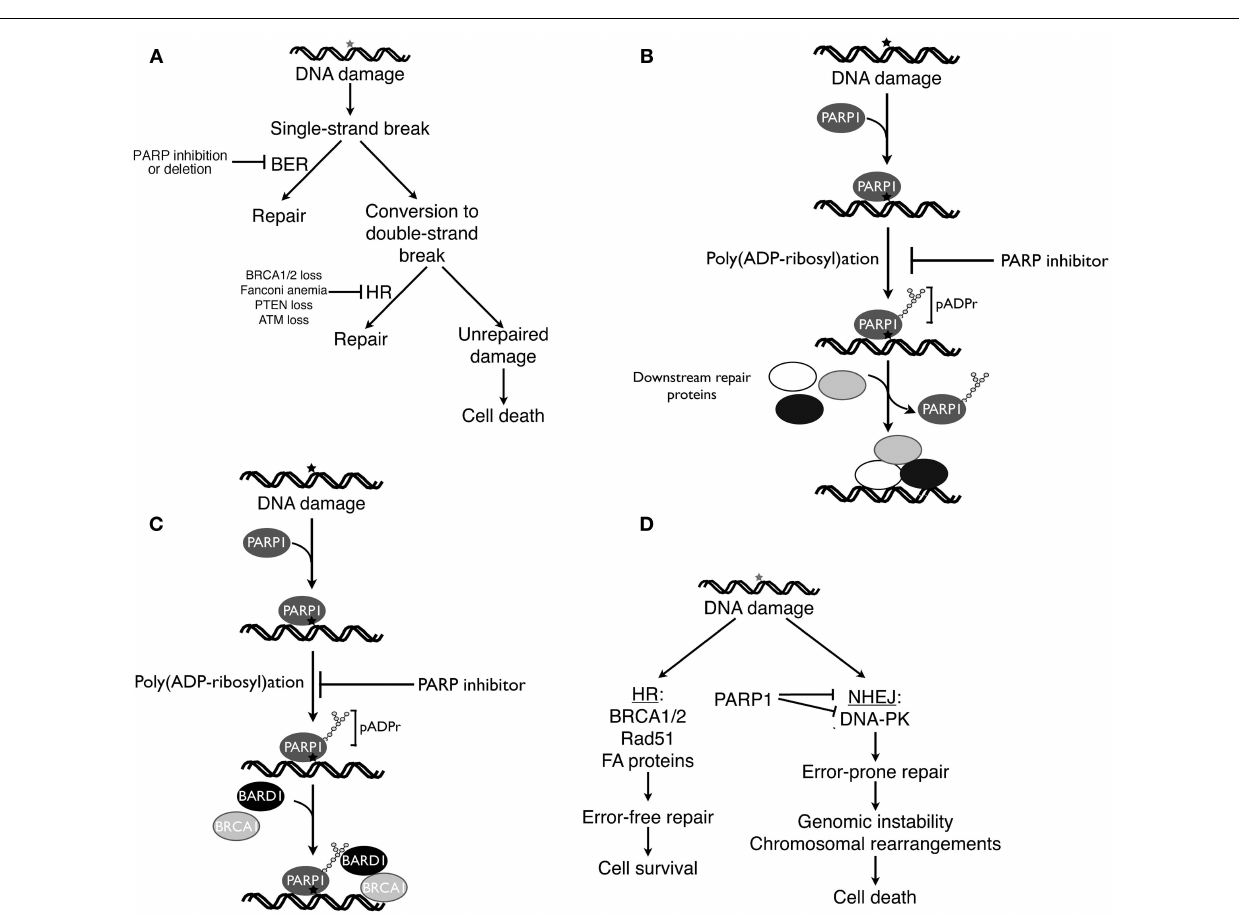
FIGURE 2 | Four current models of PARP inhibitor-induced cancer cell killing . (A) , classical explanation of PARP inhibitor cytotoxicity in HR-deficient cells (124, 125). As described in the text, endogenous DNA damage is thought to result in DNA single-strand breaks, which ordinarily would be repaired by base excision repair (BER). If PARP inhibitors prevent BER, then persistent single-strand breaks are thought to be converted to DNA double-strand breaks, which would be repaired by HR in HR-proficient cells but remain unrepaired in HR-deficient cells. (B) Model emphasizing trapping of inhibited PARP1 at sites of DNA damage. According to this model, PARP1 binds to damaged DNA, synthesizes polymer, and then is released from the DNA so that repair enzymes can bind (51). Building on these observations, this model postulates that PARP inhibition results in failure of PARP1 to dissociate from sites of damage, leading to diminished access of other repair proteins, inhibited repair, and cell death. (C) Model emphasizing impaired recruitment